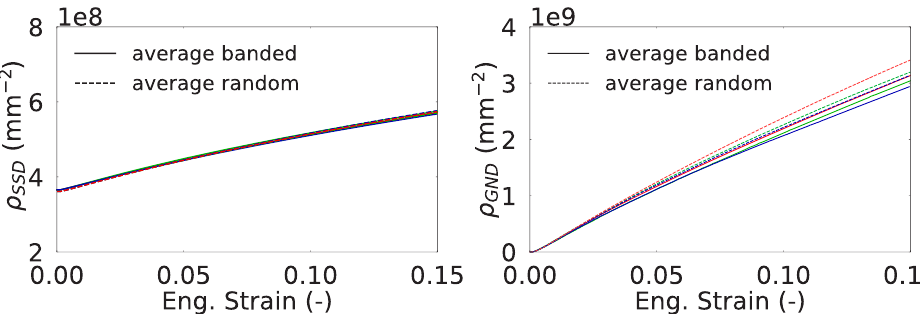
Figure 8. Averaged statistically stored dislocation (SSD) ( left ) and geometrically necessary dislocations (GND) ( right ) densities within the RVEs. Each color represents an orientation